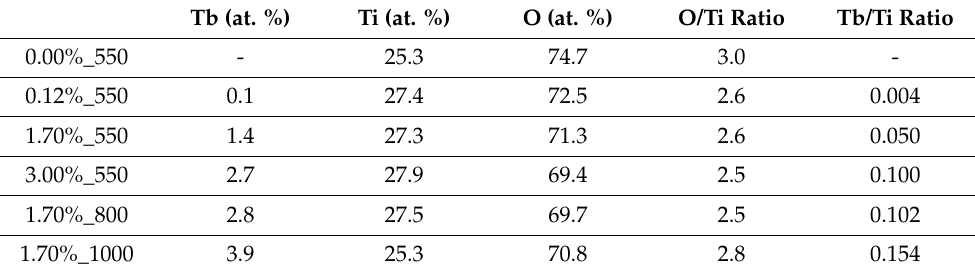
Table 2. Quantitativeanalysisofthesurfacesforselectedsamples(at.%: percentageofatomicconcentration). Tb (at. %) Ti (at. %) O (at. %) O/Ti Ratio Tb/Ti